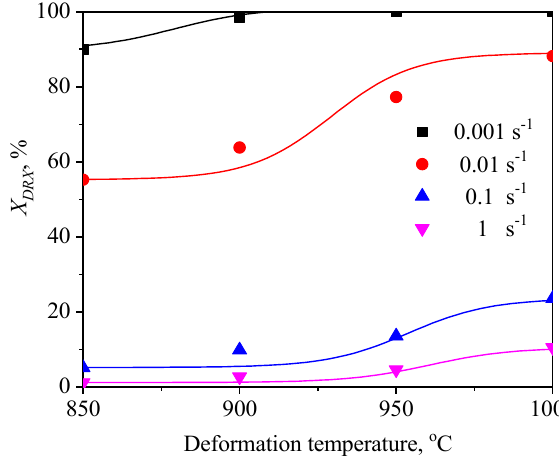
Figure 4. Variation in the volume fraction of recrystallized grains ( X DRX ) with deformation parameters.